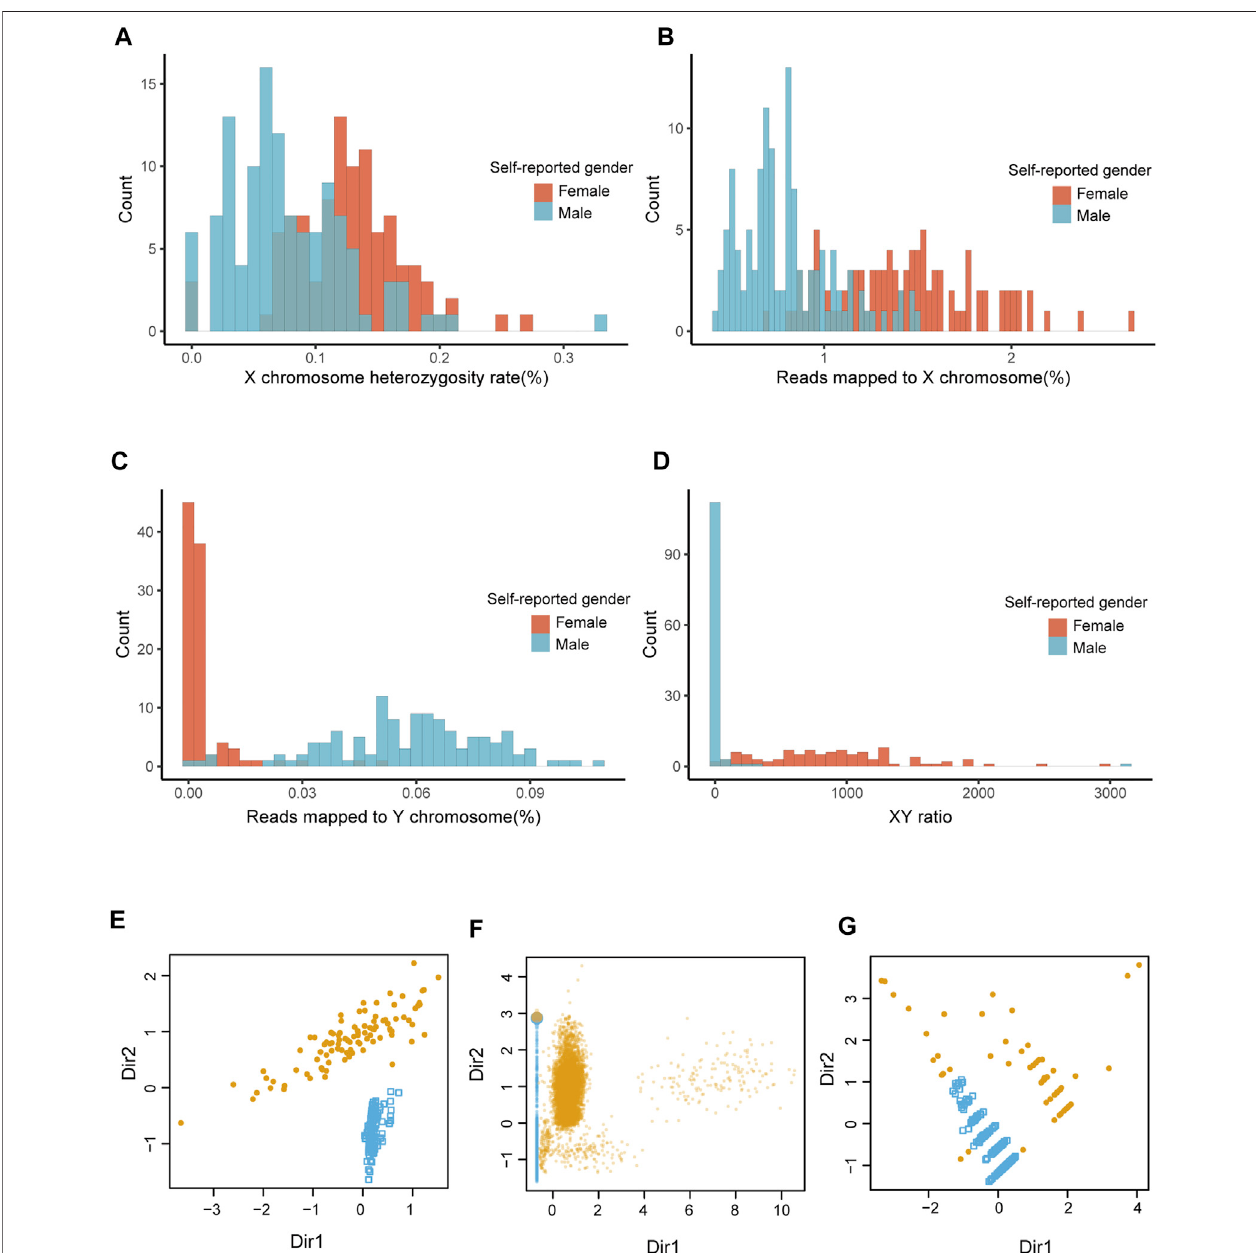
FIGURE 2 | The performance of seGMM in the TGS datasets. (A – D) Distribution of features collected from dataset 1. (E – G) Sample classi fi cation results of datasets 1, 2, and 3 based on seGMM. The colors represent different sample clusters. Dir1 and Dir2 represent the eigenvectors that specify the discriminant subspace generated from the features included in the GMM